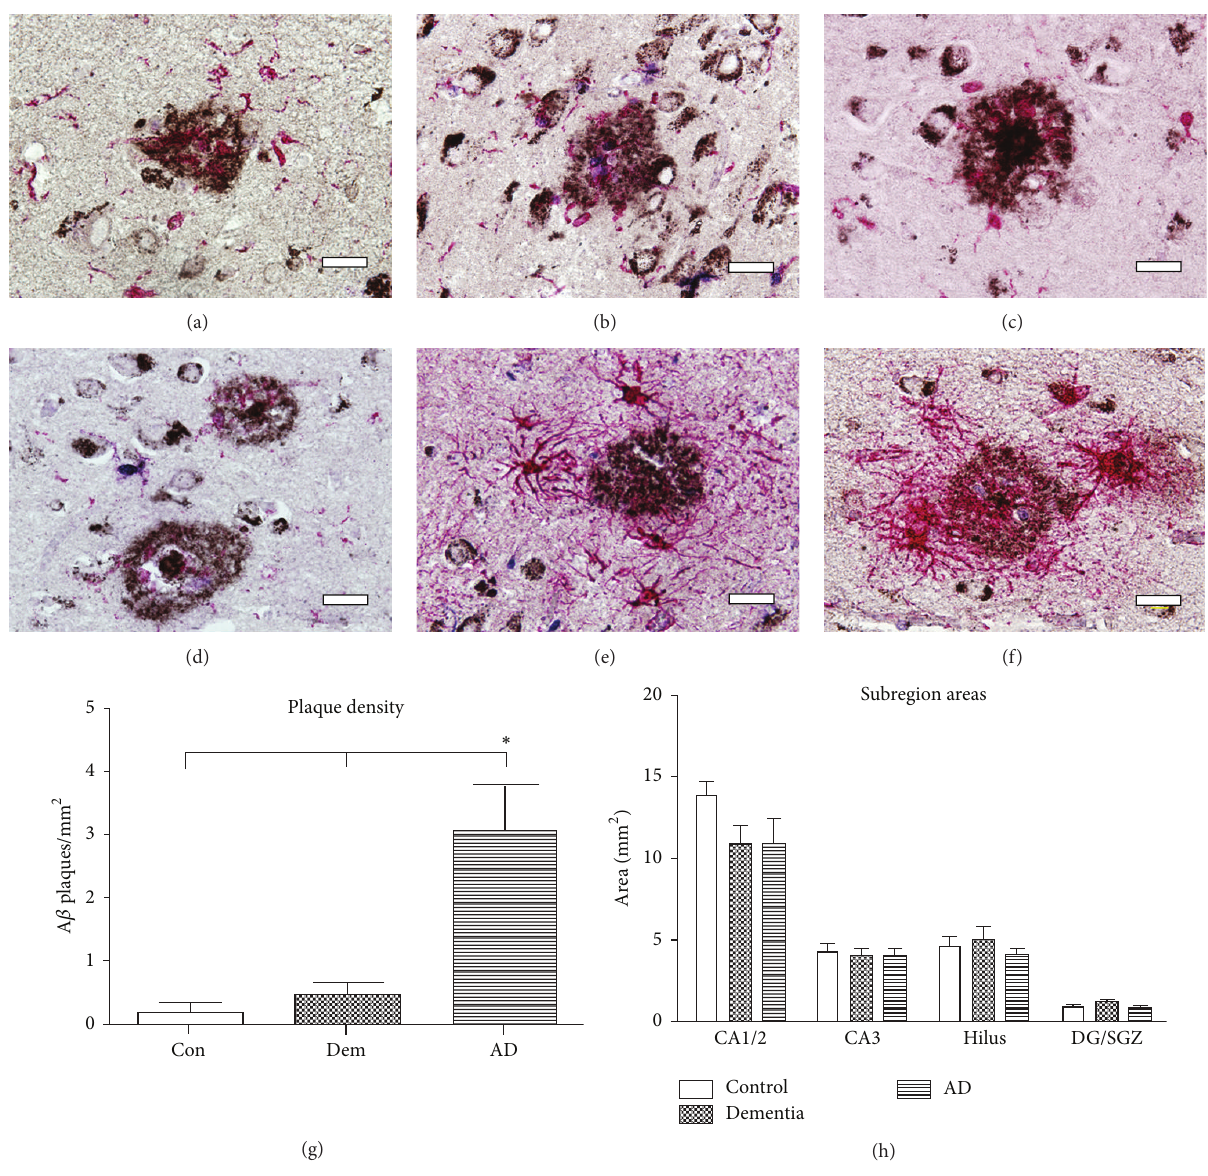
Figure 3: Glia are tightly associated with A 𝛽 plaque morphology. The same chromogen Fast Red substrate was used to visualize either microglia (a–d) or astrocytes (e–h) in these images; (a–d) Iba1+ cells infiltrate A 𝛽 plaques and appear involved in the formation of dense-core plaques: (b) proliferating Iba1+ cells (arrowhead) are seen within primitive plaques, (c) a dense-core plaque with concentric Iba1+ cells, and (d) a mature dense-core plaque without concentric Iba1+ cells. (e-f) GFAP+ astrocytes participate in degradation of multiple plaque subtypes; proliferating cells (arrowheads) within the borders of plaques degraded by GFAP+ astrocytes. Scale bars (a–f) = 50 𝜇 m. (g) Plaque load was significantly increased in the AD cohort compared to Con and Dem cohorts (one-way ANOVA 𝑃 < 0.001 ). (h) Hippocampal cross-sectional areas were not significantly